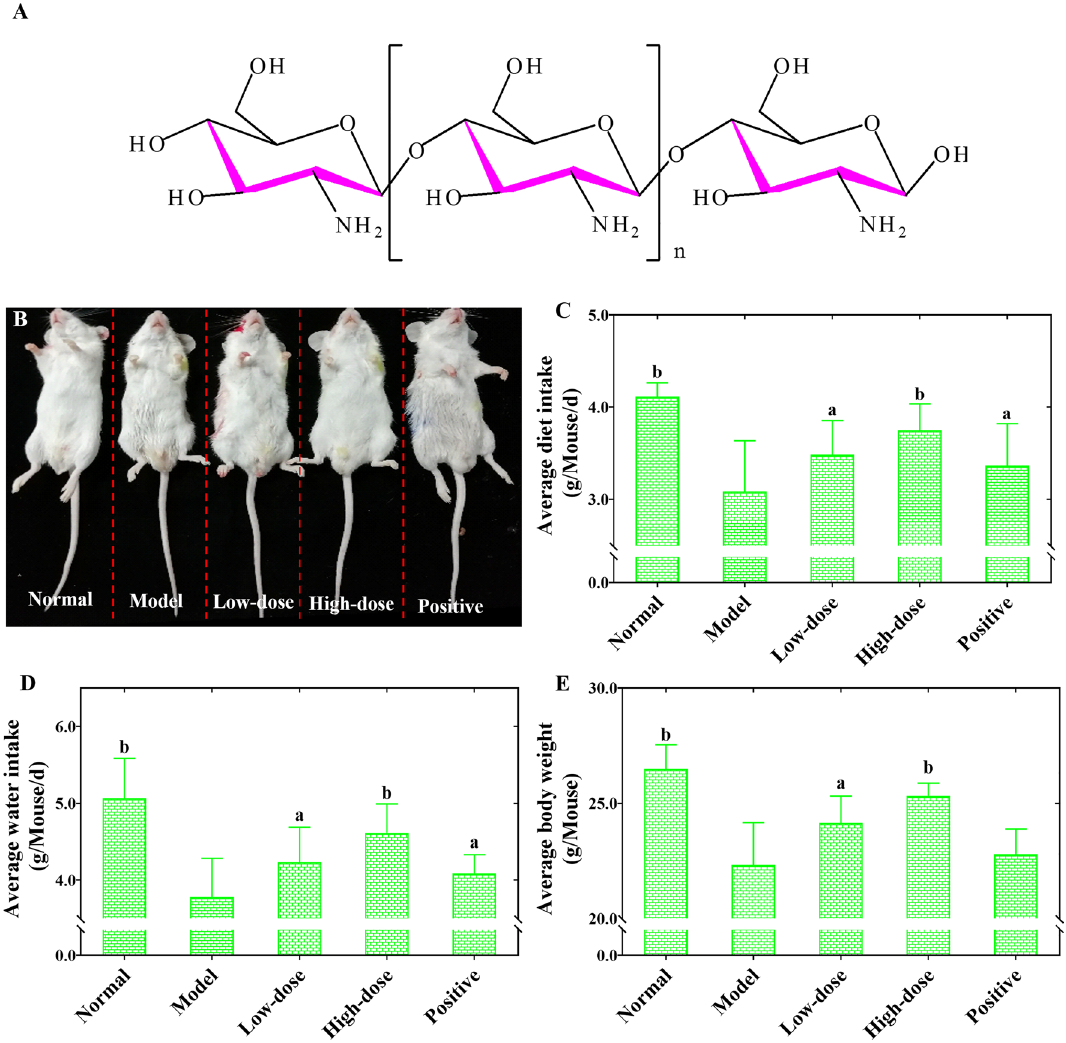
Figure 1. Chemical structure ( A ) and the effects of COS ( B – E ) on the clinical symptoms in UUO-induced RF mice. Representative somatotype pictures of mice in each group ( B ). Diet changes ( C ). Water intake changes ( D ). Body weight changes ( E ). All values are represented as mean ± SD (n = 10 in each group). Superscript letters a and b designate significant differences. a P < 0.05 compared with the model group. b P < 0.01 compared with the model